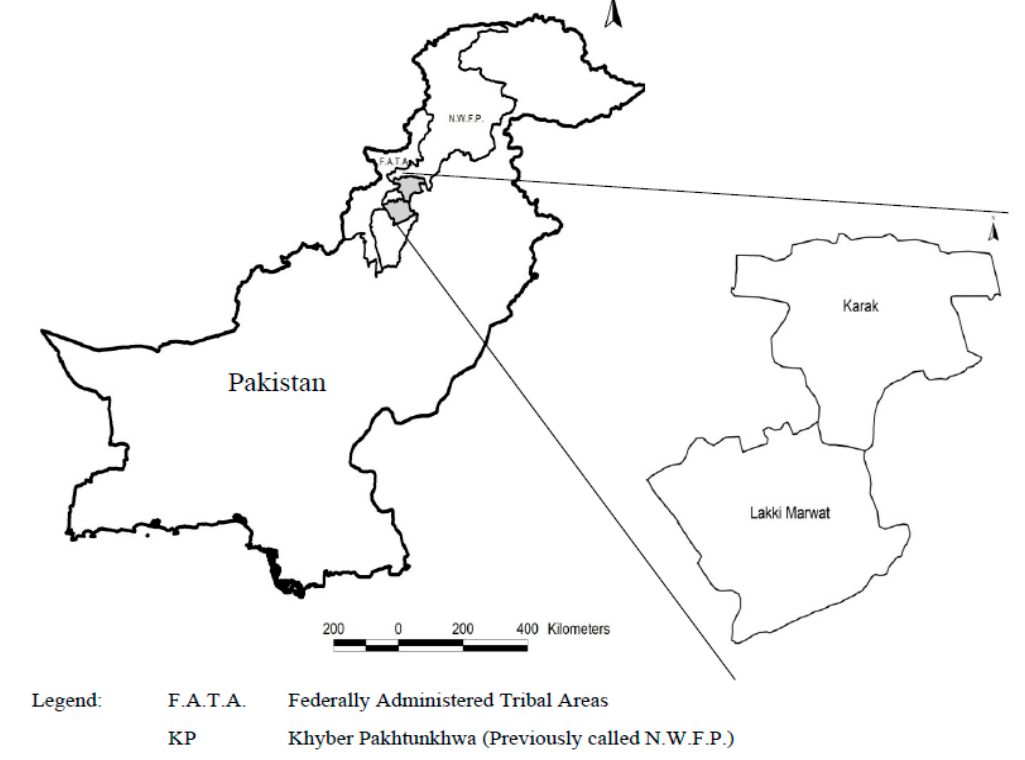
Figure 1. Map of the study area.